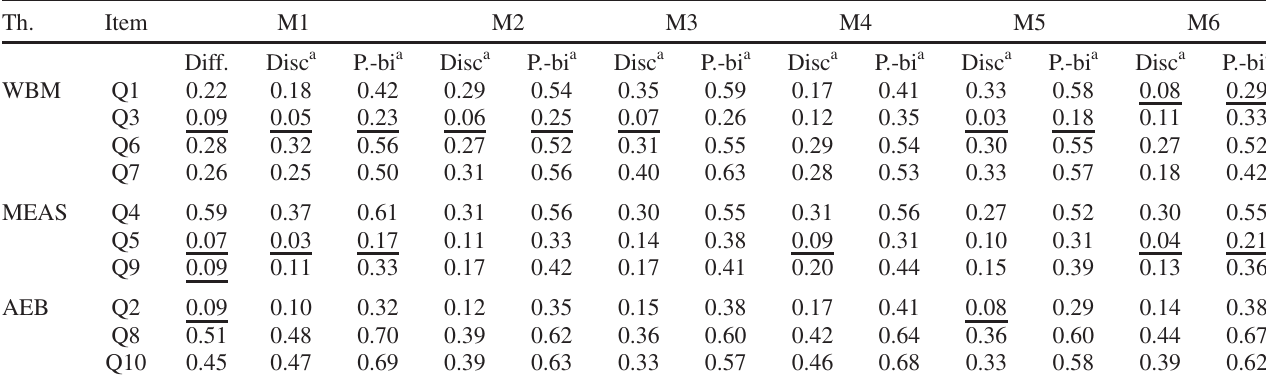
TABLE VII. Classic test theory statistics for QME scoring methods M1 – M6 (coupled tier).